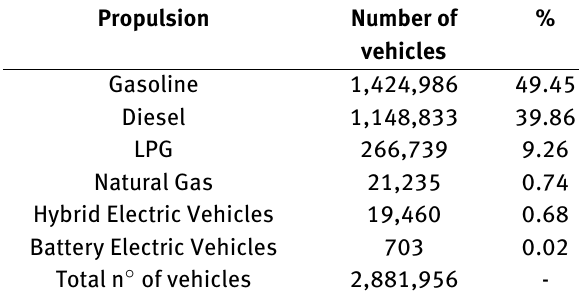
Table 1: Fleet composition of